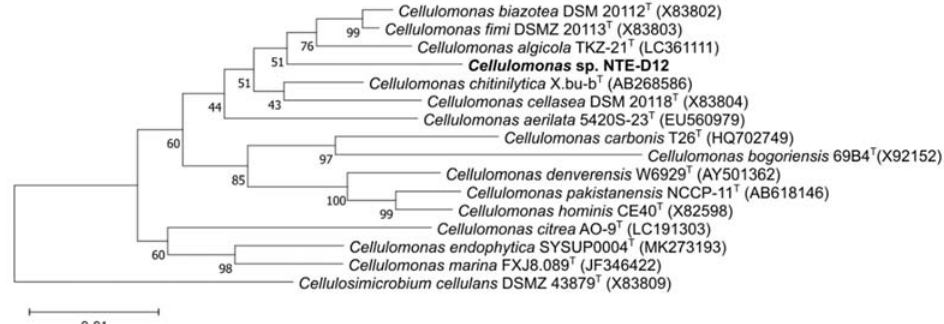
Figure 2. Phylogenetic tree with the novel isolated strain NTE ‐ D12. Numbers at branch points are percentages supported by bootstrap probabilities with 1000 replicates. Bar, 0.01 nucleotide substitution position.